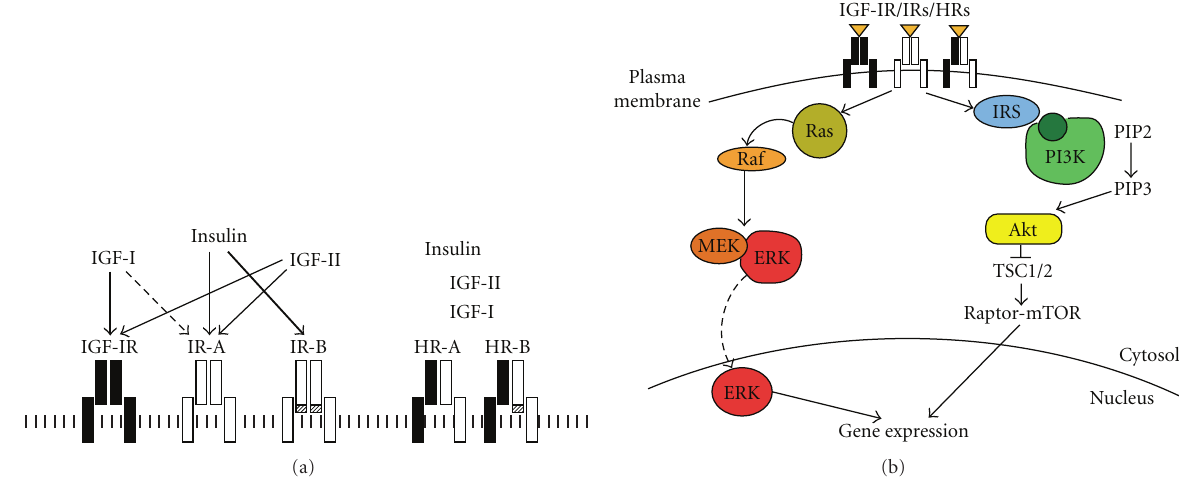
Figure 1: The IGF system: receptors, ligands, and signaling pathways. (a) Schematic representation of the major receptors and ligands involved in the IGF system. Insulin receptor isoforms (IR-A or IR-B) binds insulin with high a ffi nity, while IGF-I receptor (IGF-IR) binds IGF-I and IGF- II (left). In cells expressing both IR and IGF-IR, IR hemireceptors may heterodimerize with IGF-IR hemireceptors, leading to the formation of hybrid IR/IGF-IRs (HRs), which bind IGF-I and IGF-II with high a ffi nity and insulin with a much lower a ffi nity (right). (b) The IGF system signaling pathways . Schematic representation of the two major signaling pathways involved in IGF system. IGF-I, IGF-II, and insulin bind to their cognate receptors, leading to the activation of the PI3K/Akt/mTOR pathway and of the Ras/Raf-1/MEK/ERK